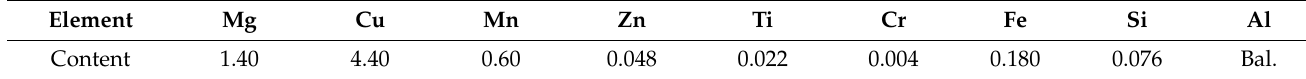
Table 1. Chemical composition of 2A12-T4 alloys (wt.%).